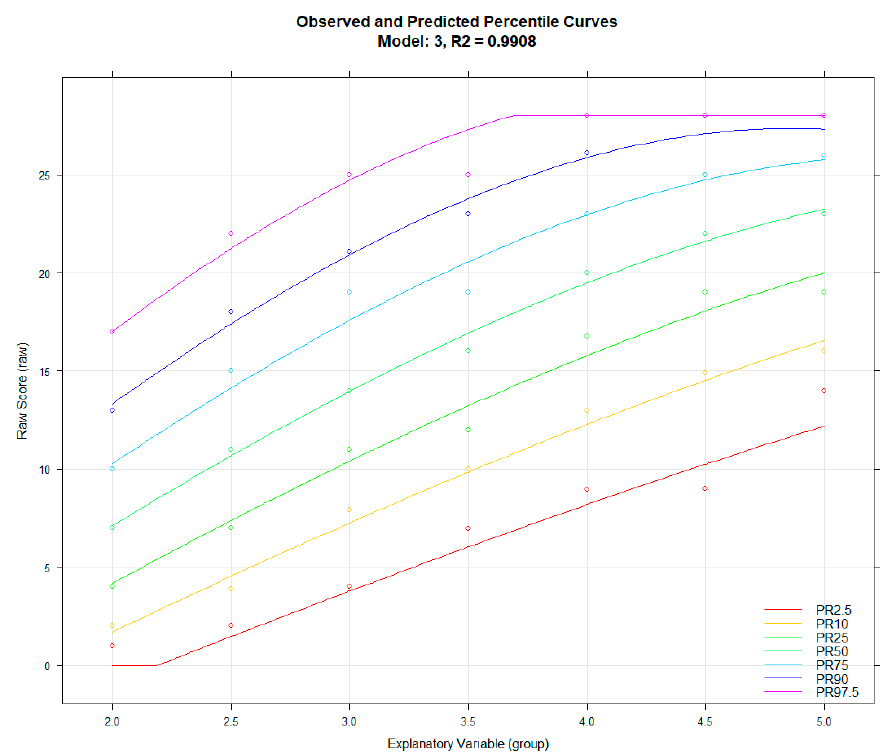
Figure 5. Observed (circles) and predicted percentile curves.